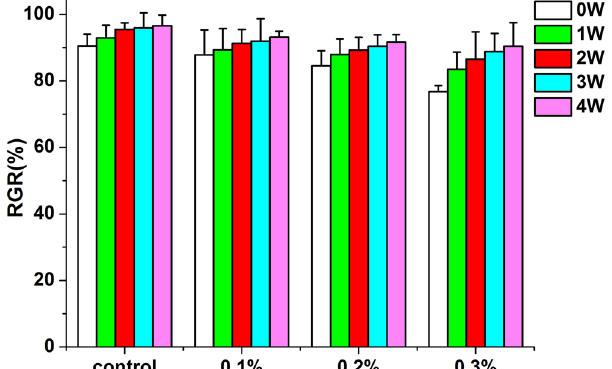
Figure 8. Cytotoxicity of PMMA resin with or without AgBr/NPVP. The values of the RGR ranged from (76.76 ± 1.84)% to (96.58 ± 3.23)%. The cytotoxicity of the PMMA resin decreased with the time and the decrease of AgBr/NPVP. When the dosage of AgBr/NPVP was 0.3 wt%, there were statistically difference (p < 0.05) between aging 3 and 4 w and the control group. There were no statistically differences between the groups with the rest dosages with the time (p > 0.05). There were statistically difference (p < 0.05) between 0.3 wt% and control group and 0.1 wt% group of before aging, also between 0.3 wt% and control group after aging 1 w. The rest aging groups had no statistical differences (p > 0.05) among different